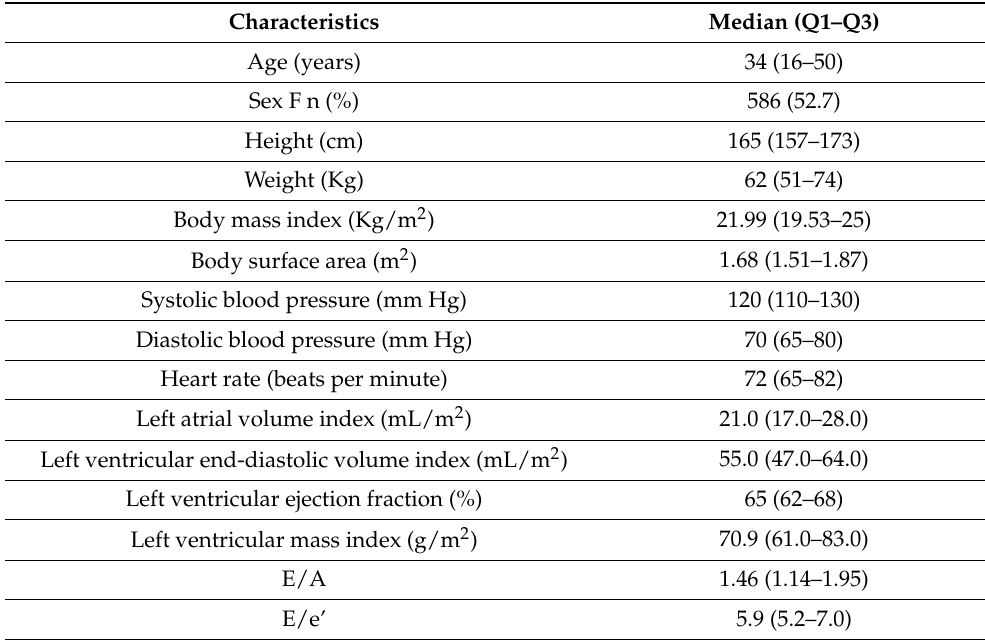
Table 1. Demographic and echocardiographic characteristics of the 1112 healthy subjects.